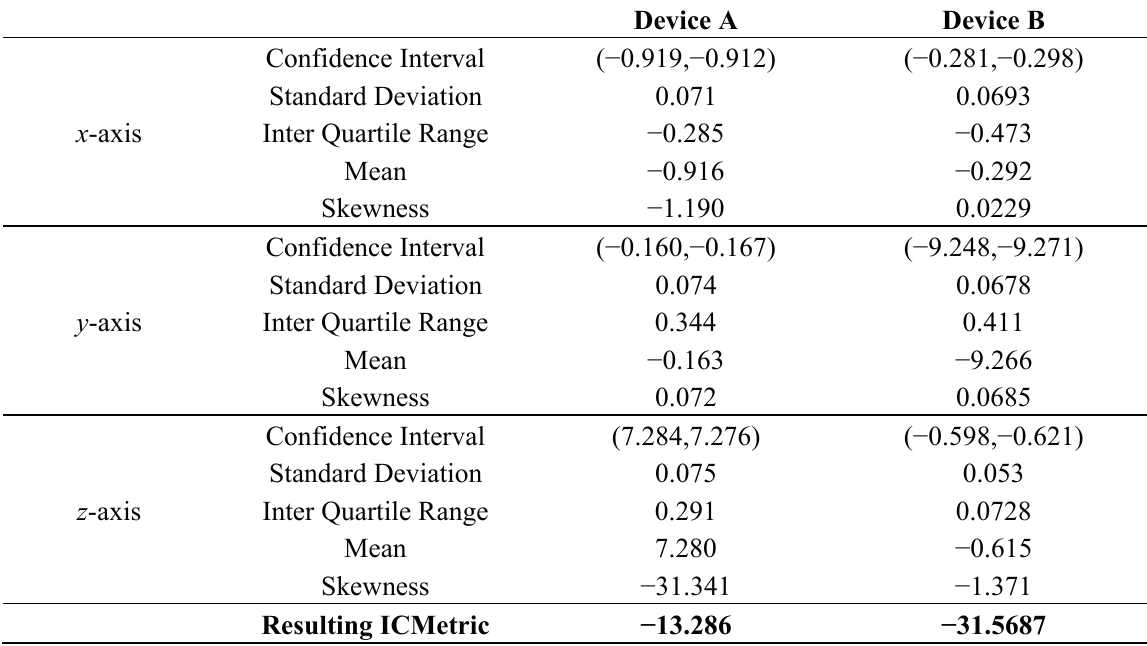
Table 2. Statistical analysis of the normal distribution for two different devices A and